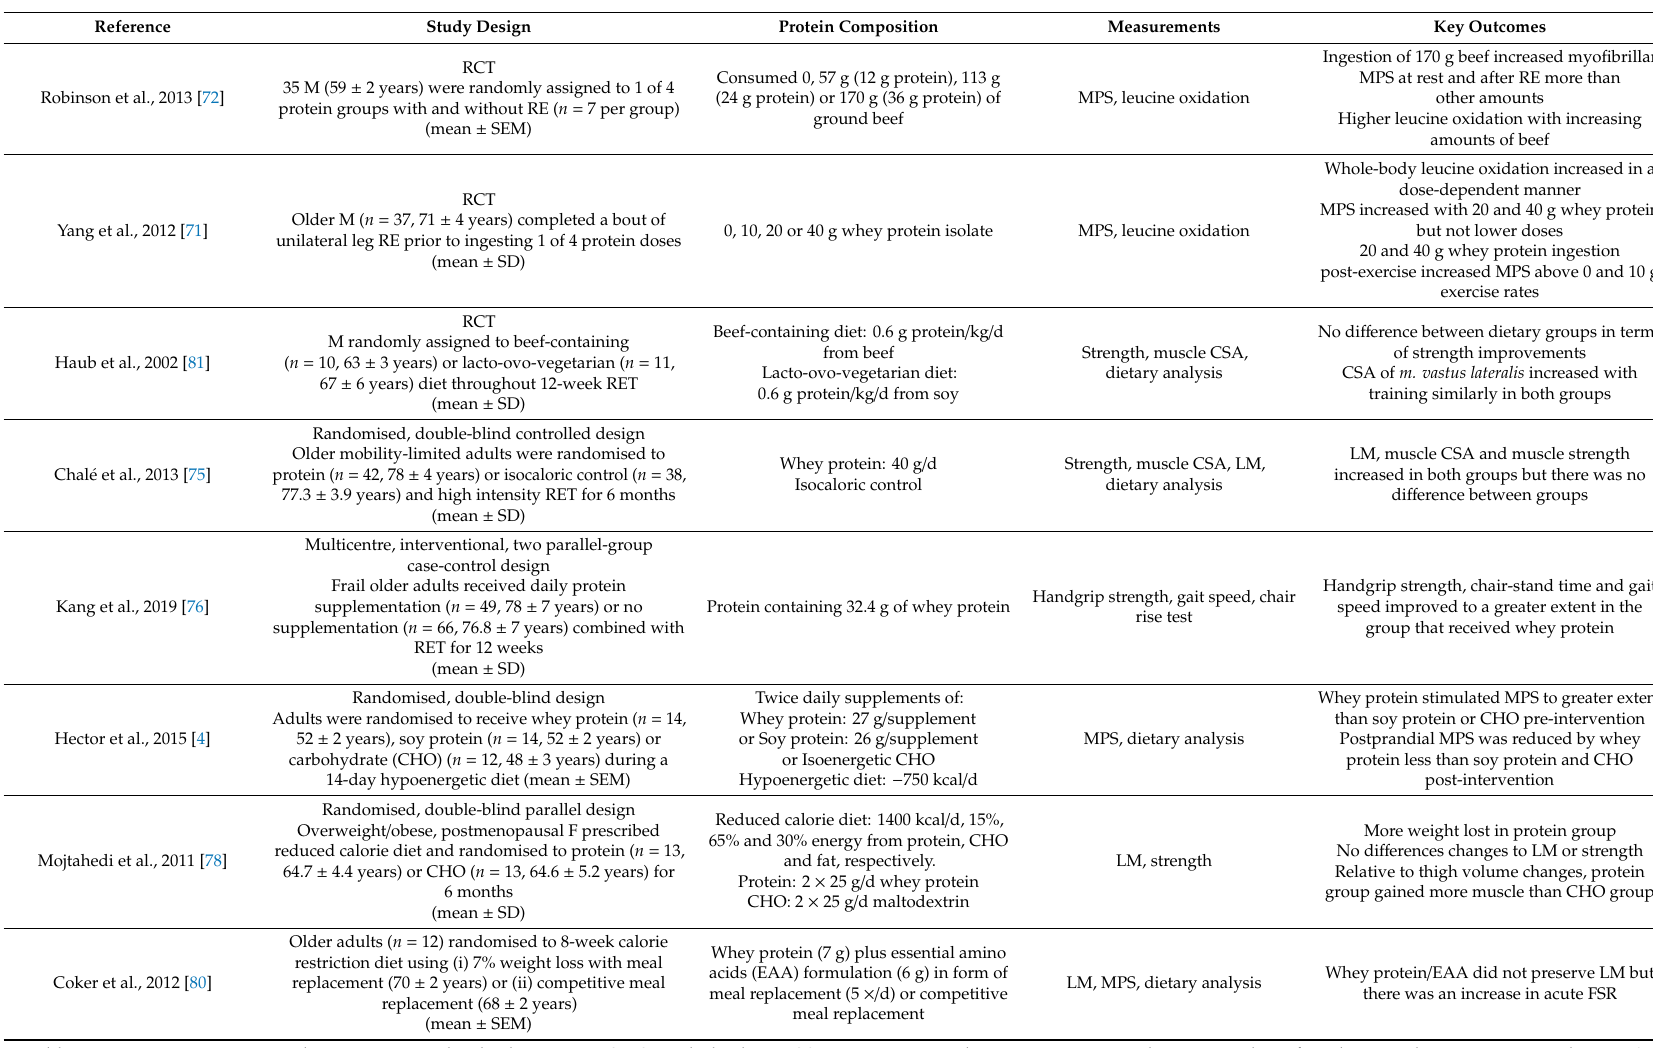
Twice daily supplements of: Whey protein: 27 g /